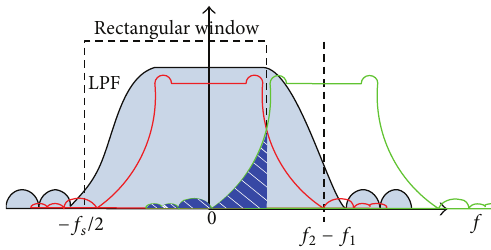
Figure 3: Separation of two frequency-adjacent